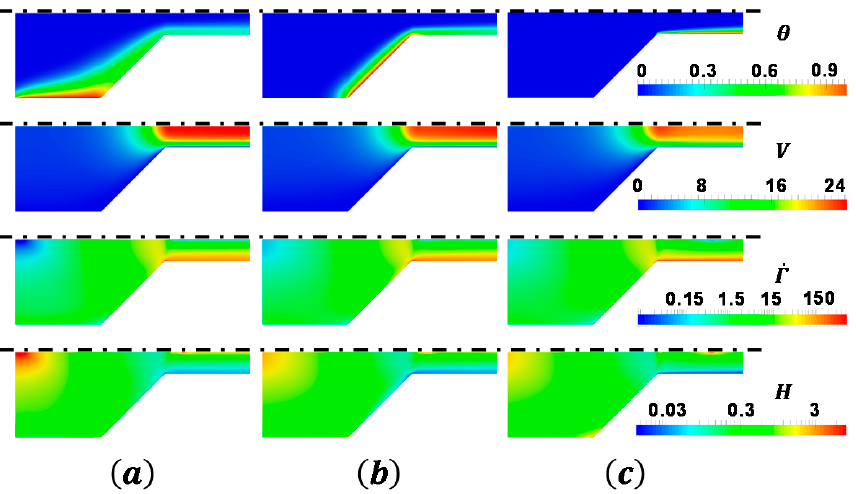
Figure 13. Contours of the dimensionless temperature, velocity, shear rate and apparent viscosity when the walls of ( a ) the upstream isometric section, ( b ) the convergent section and ( c ) the downstream section are heated with a constant temperature. The dimensionless temperature at the inlet and the hot wall are 0 and 1, respectively. Re gen = 2.3 × 10 − 2 .